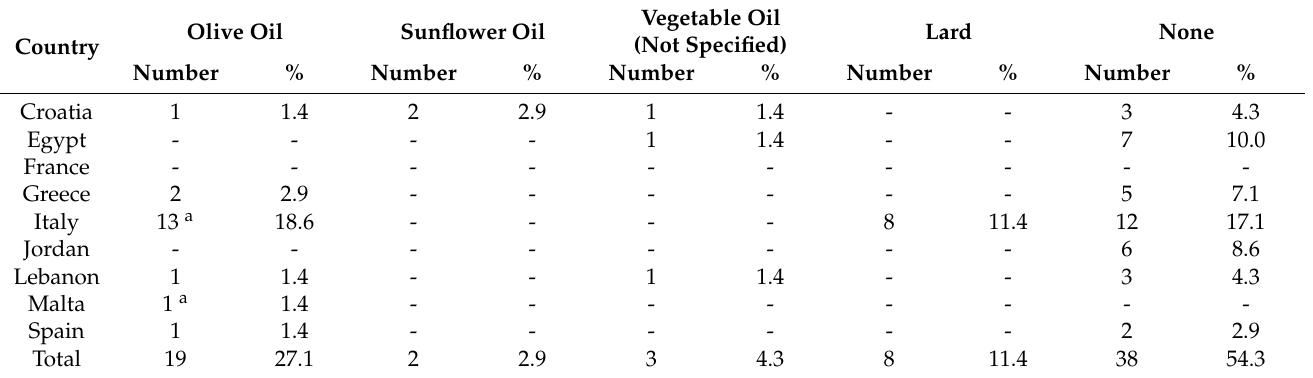
Table 3. Type of fat eventually used in plain flat breads. Multiple answers were admitted, because breads could be prepared with different oils and fats or with